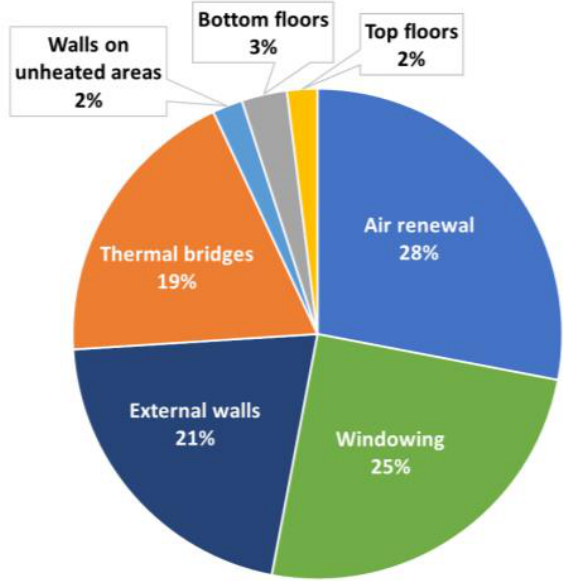
Figure 5. Distribution of heat loss by type.